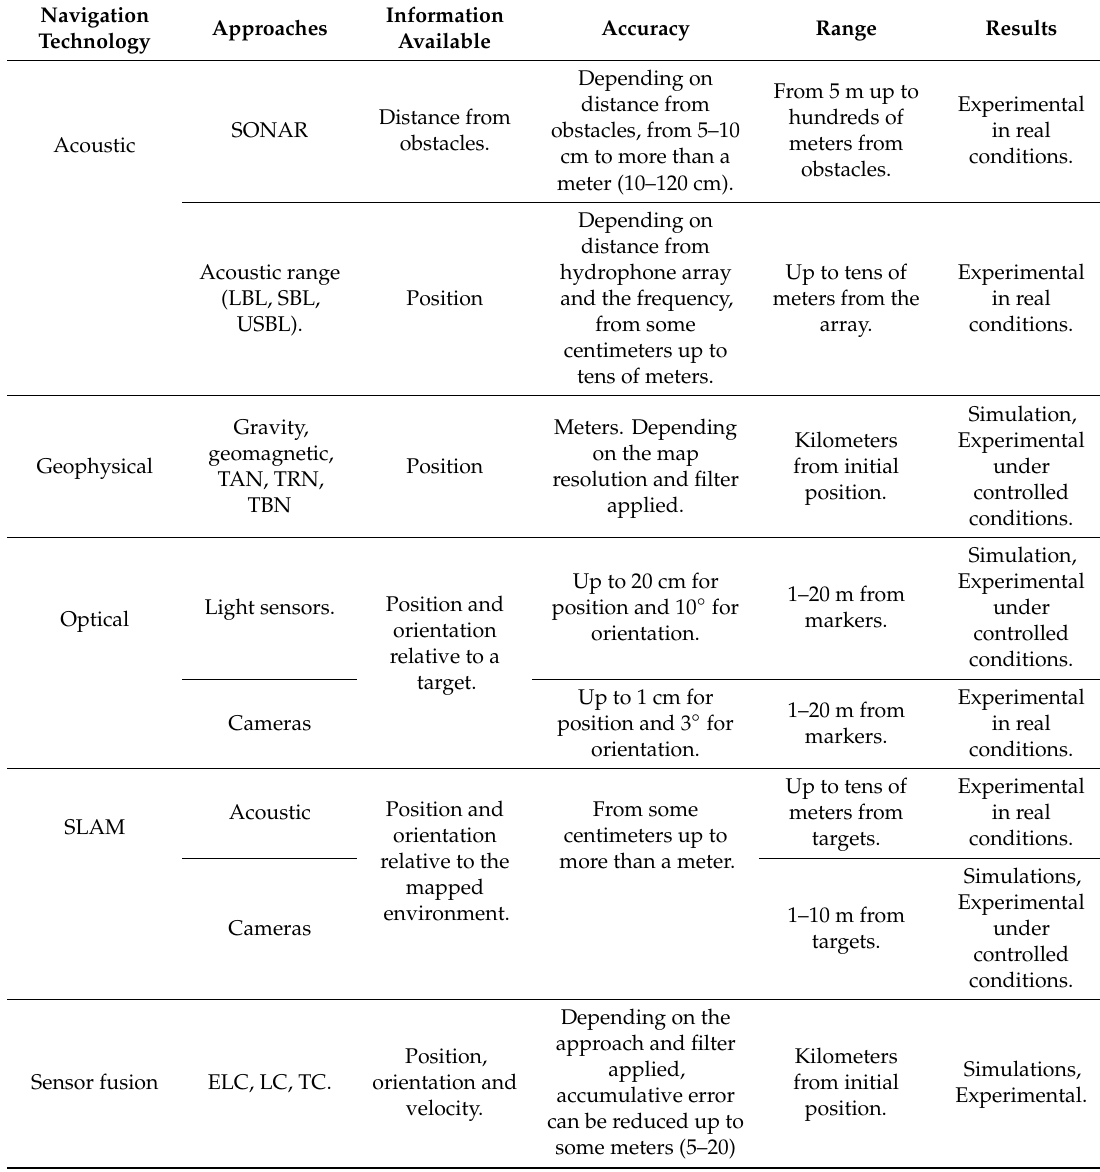
Table 4. Technologies for AUV localization and